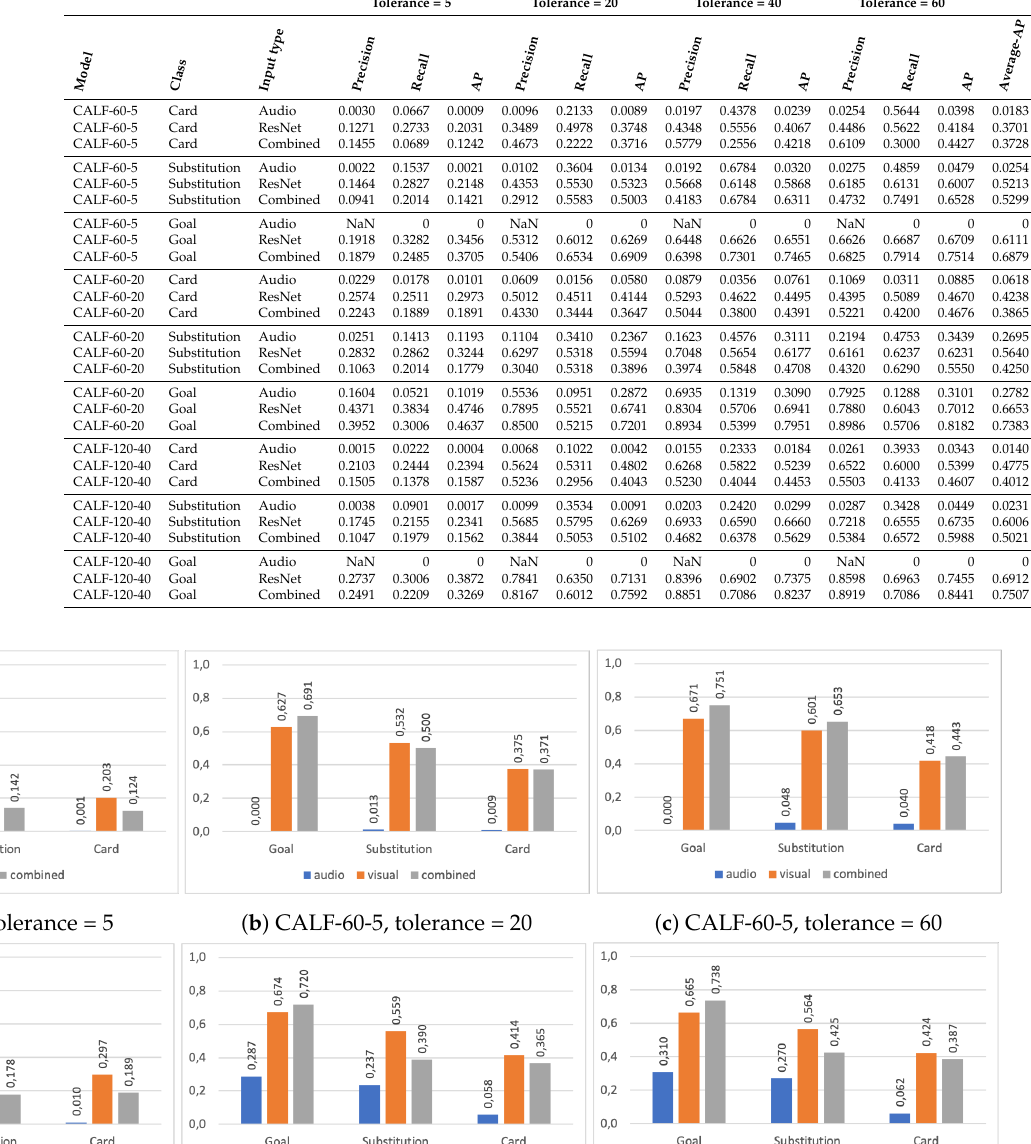
Table 9. Comparison of precision, recall, and F1-score per class (event type), for the CALF [4] model with different configurations. Highlighted cells indicate the best Average Precision score in each individual experiment. The Combined input type is the integration of the ResNet and the audio models.